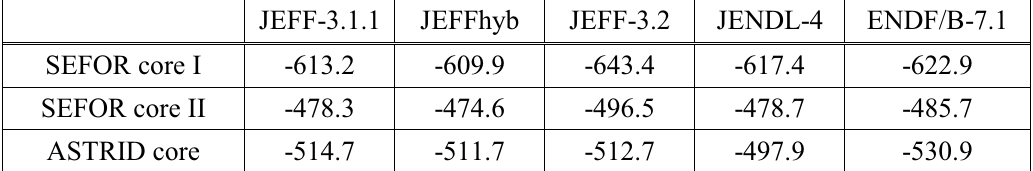
Table V. Total Doppler Effect (in pcm) using different evaluated nuclear data libraries